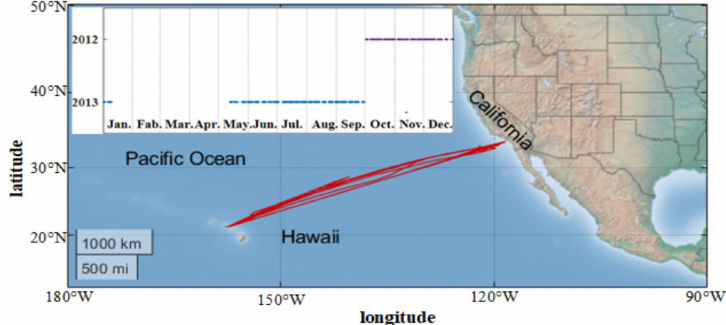
Figure 2. The spatial and temporal distribution of MAGIC measurements.